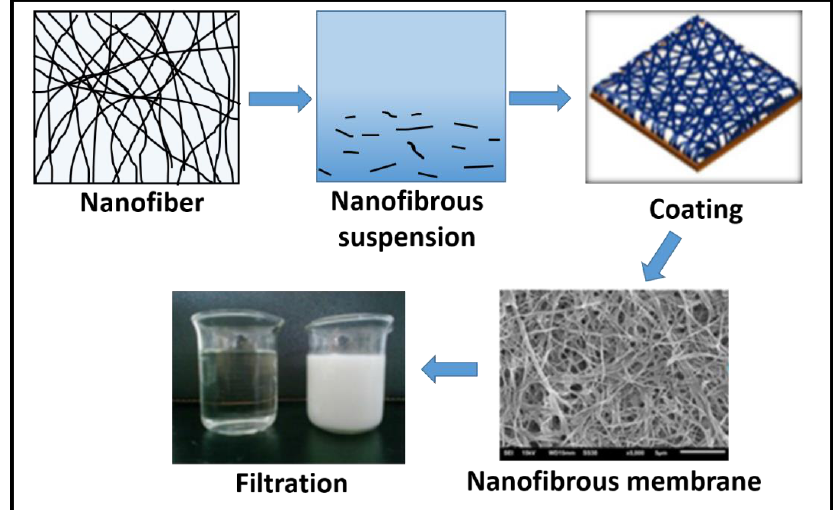
Figure 1. Nanofiber preparation and separation of the TiO 2 suspension Adopted from Ref. [32].